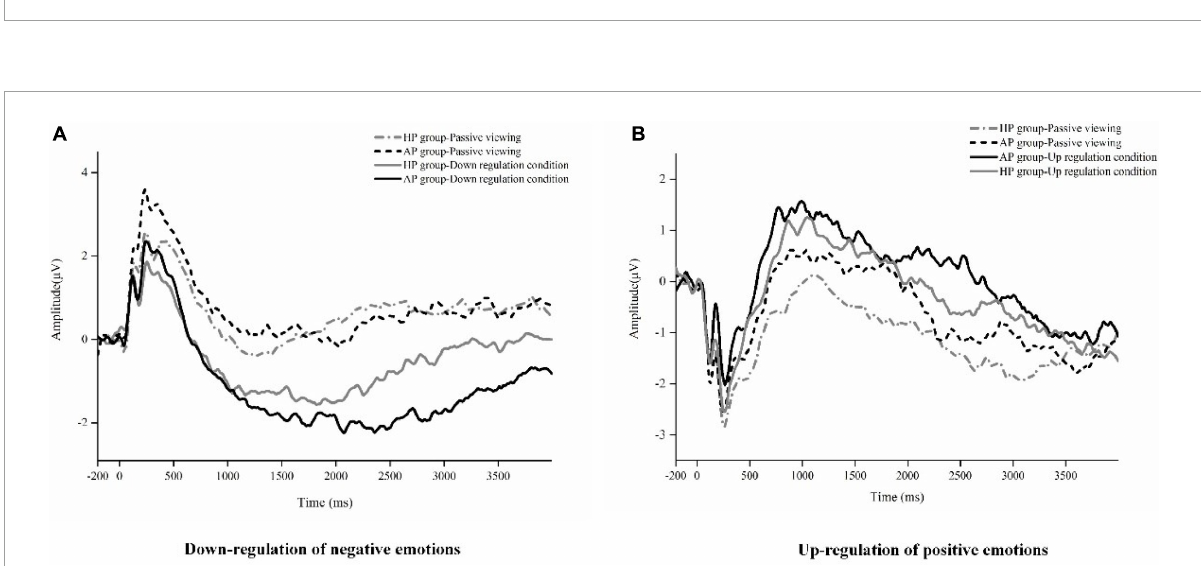
FIGURE4 The mean scores of valence rating and arousal rating of different emotional regulation conditions in AP group and HP group. *** p < 0.001, ** p < 0.01, * p < 0.05.